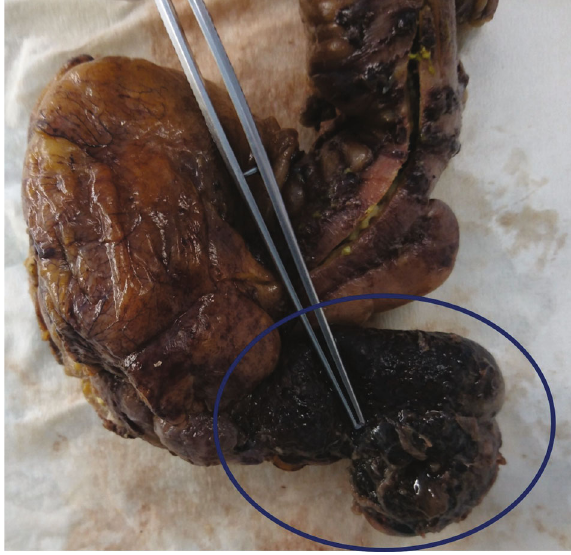
Figure 2: Gross specimen showing the dilated